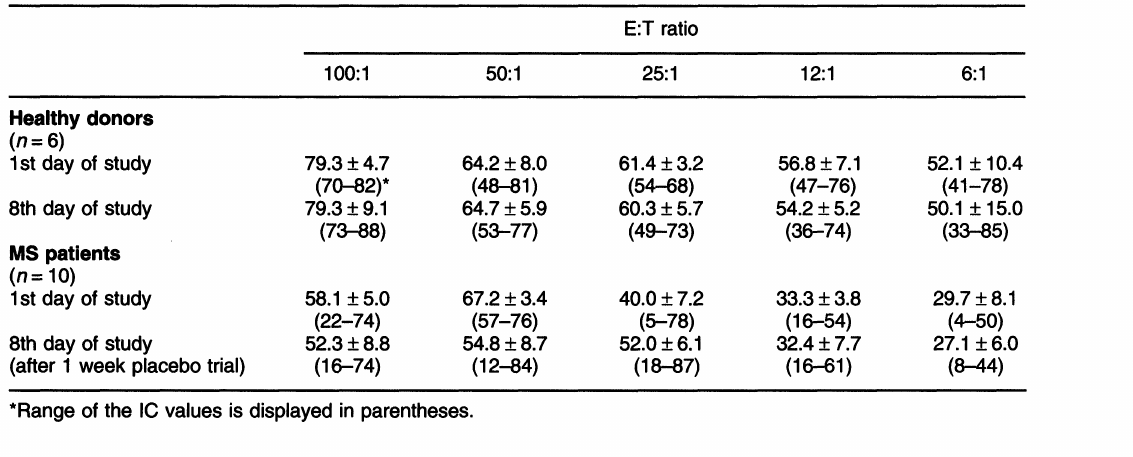
Table 4. Dynamics of NK activity of PBL on the 1st and 8th days of the study (IC in per cent, M _+ m)